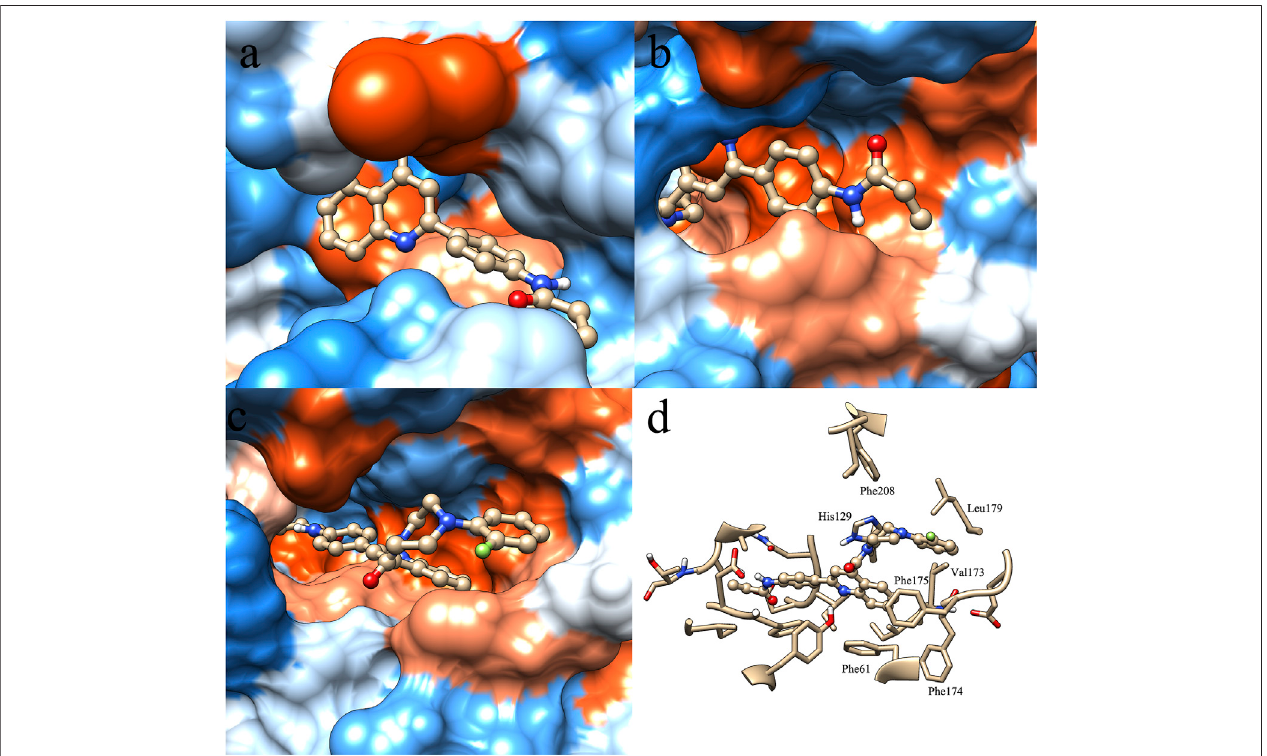
FIGURE 2 | Binding pattern of molecule P6 in the active site of SIRT1 (A) , SIRT2 (B) and SIRT3 (C,D) .